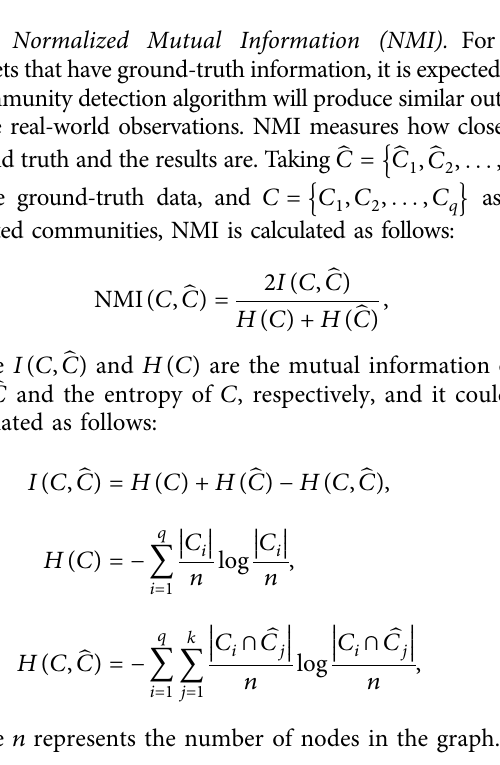
Figure 4: Te efect of α on the shape of the probability distribution. (a) α parameter has been set equal to 0, and mutation probability is directed toward border edges, (b) setting α � 0 . 5 results in a uniform probability distribution, and (c) shows the probability distribution of the edges when α � 1. Te mutation probability of inner edges is